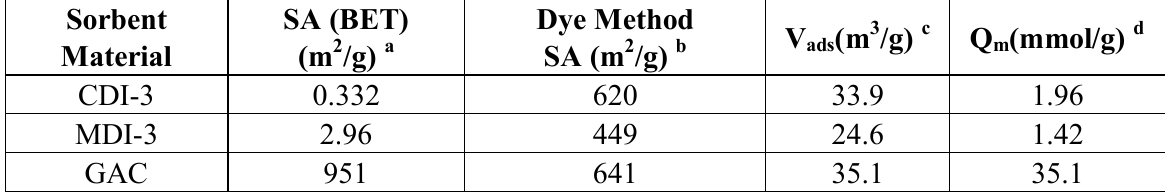
Table 2. Textural parameters of nanoporous copolymer materials derived from nitrogen adsorption at 77 K and dye-based estimates of the surface area (SA), V copolymer materials at 295 K and pH 4.60 in aqueous solutions containing